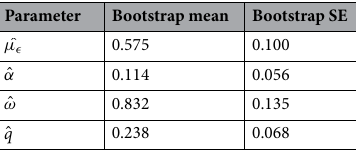
Table 2. Bootstrap means and standard errors of the proposed model for the HPV example.